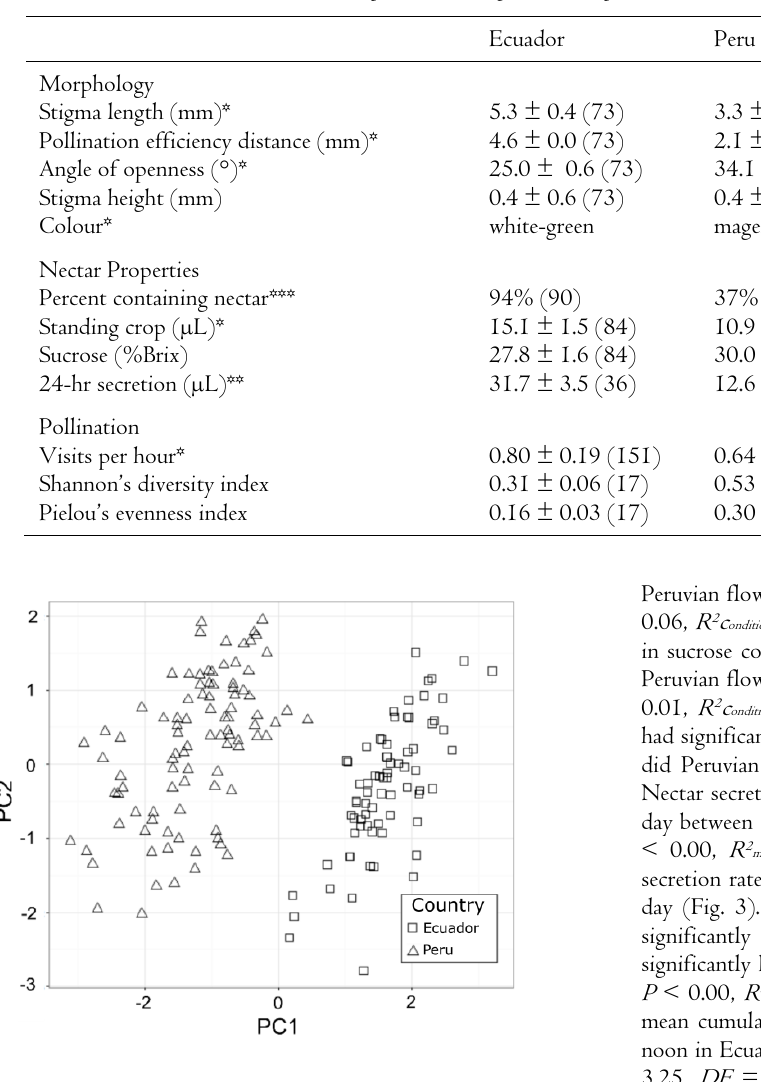
Figure 2. PCA results for a comparison of floral morphology in Peruvian (N = 94) and Ecuadorian (N = 73) populations of Oreocallis grandiflora. Squares represent Ecuadorian samples and triangles represent Peruvian